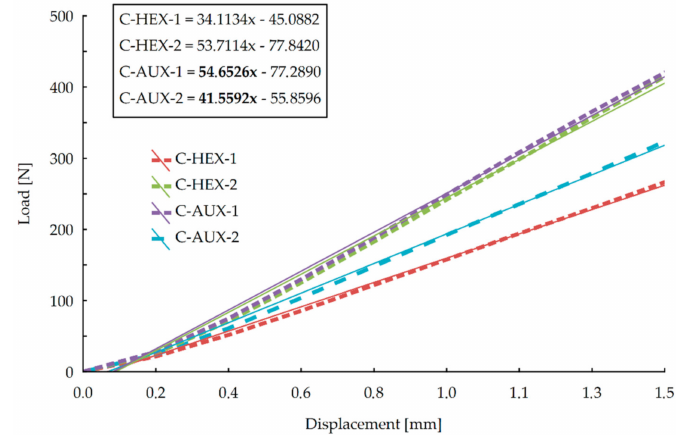
Figure 6. Sti ff ness of joints in compression test in the linear elasticity range.